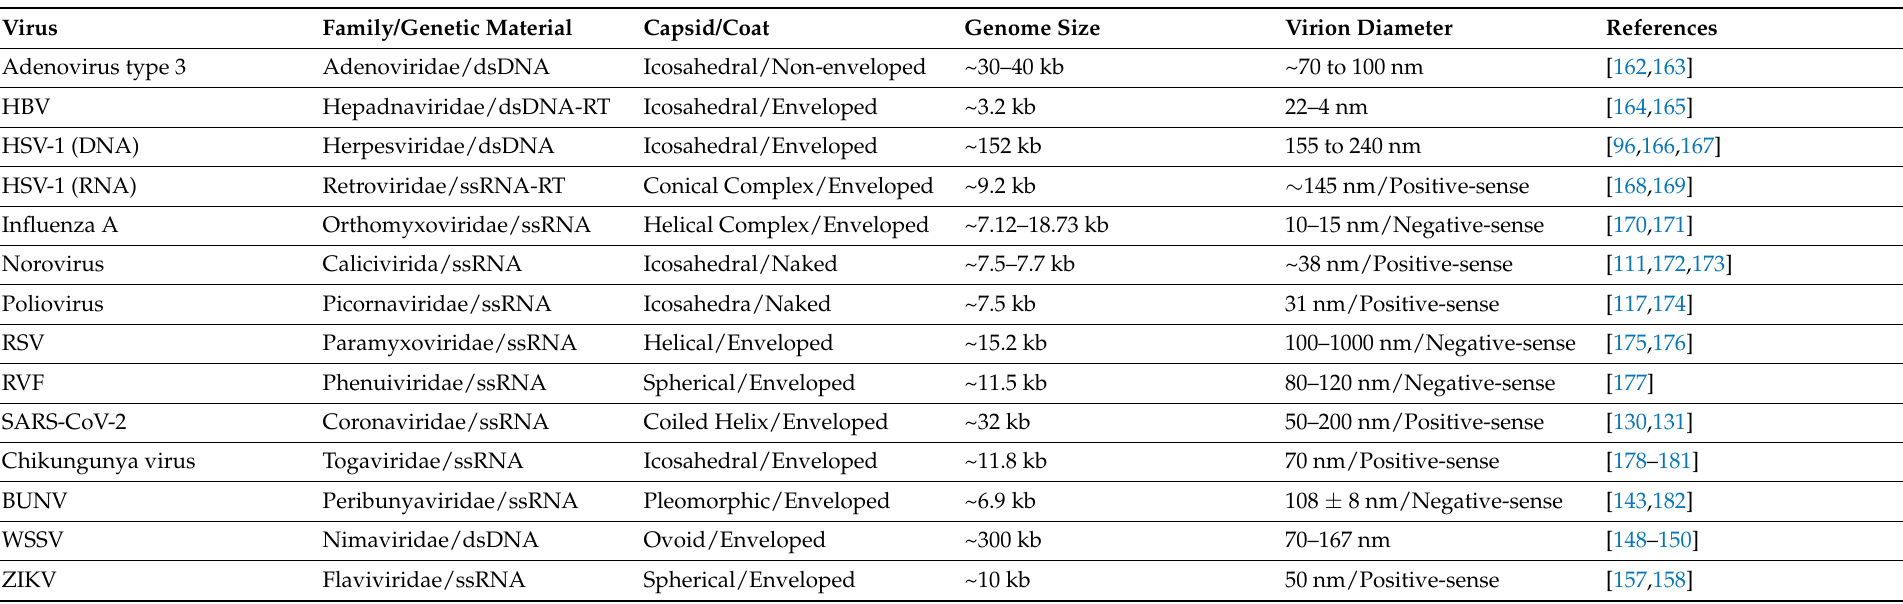
Table 1. Properties of viruses included in AgNP